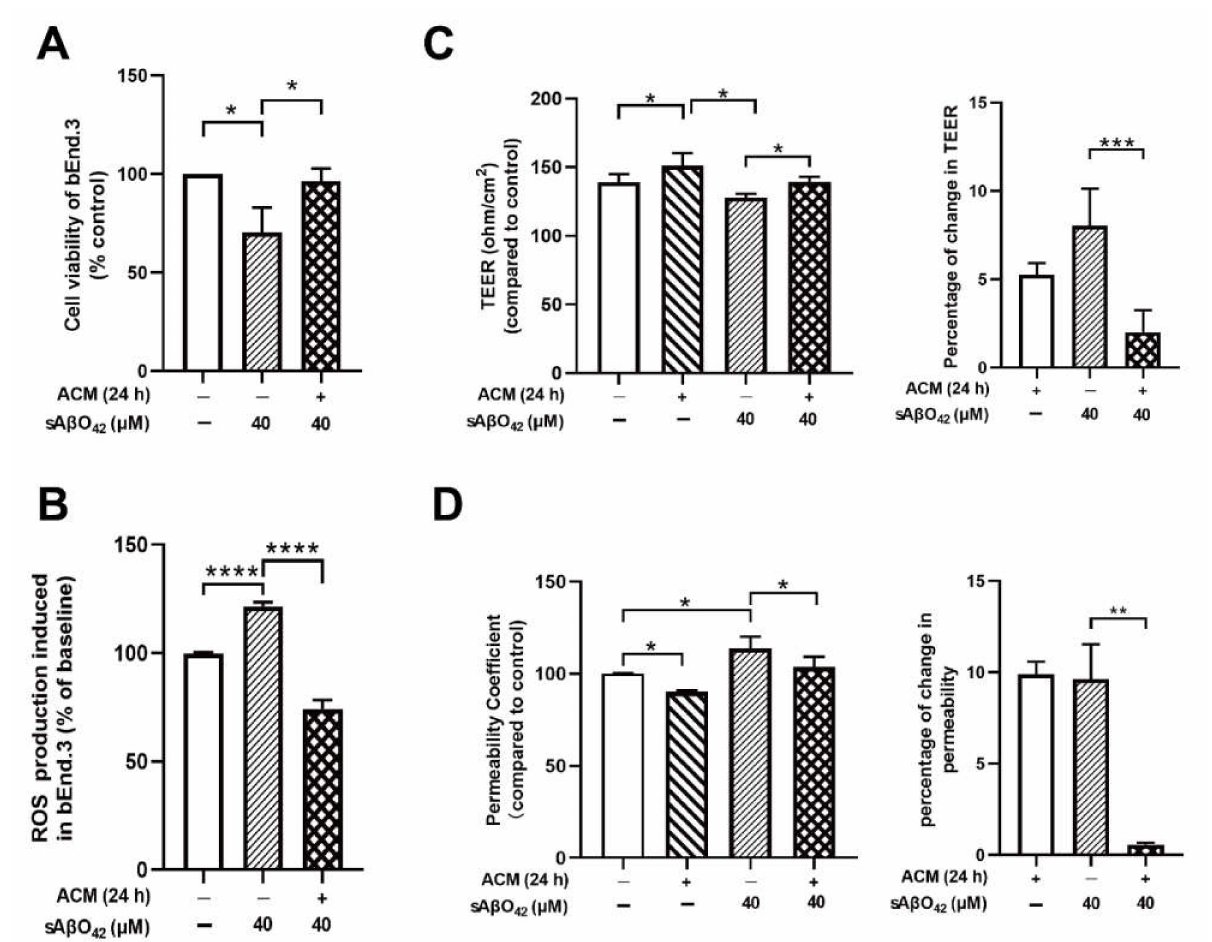
Figure 6. Resting ACM protected cell survival and barrier function of the bEnd.3 monolayer against sA β O42 stimulation. ( A ) Cell viability and ( B ) ROS generation in bEnd.3. ( C ) TEER value and ( D ) permeability of FITC-dextran across the bEnd.3 monolayer. Data are shown as means ± SD of at least three independent experiments and were analyzed by one-way ANOVA followed by a post hoc Dunnett’s test and a post hoc Tukey’s test. * p ≤ 0.1, ** p ≤ 0.01, *** p ≤ 0.001, **** p ≤ 0.0001